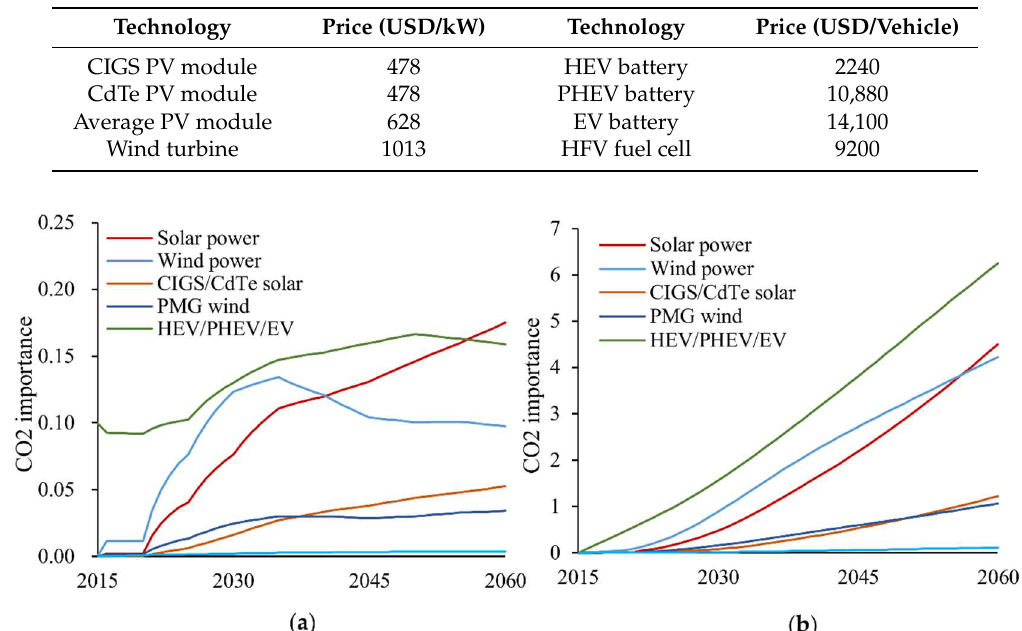
Table A1. Technology price in 2015.